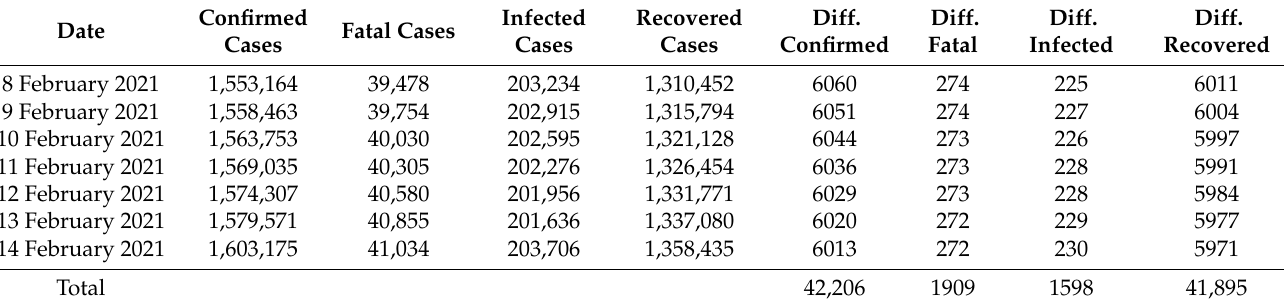
Table 4. Simulation of the SIR-F model in the sixth week of